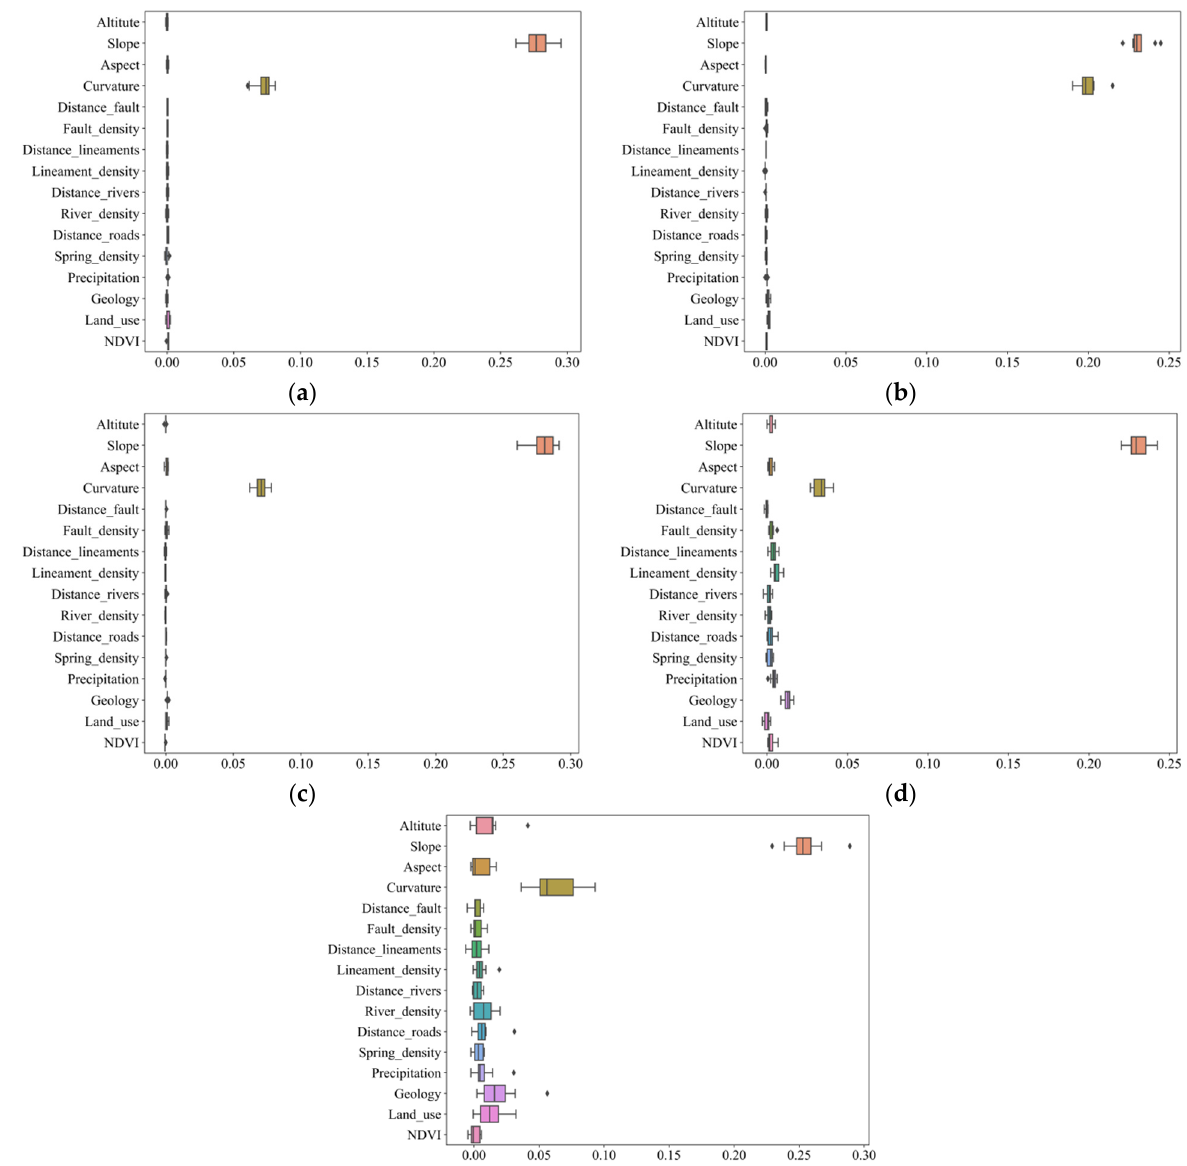
Figure 7. Assessed importance values of the landslide causative factors employing the five machine learning models: ( a ) LR; ( b ) ANN; ( c ) SVM; ( d ) RF; ( e ) CNN, X -axis demonstrates the values of PVAI and Y -axis shows the landslide causative